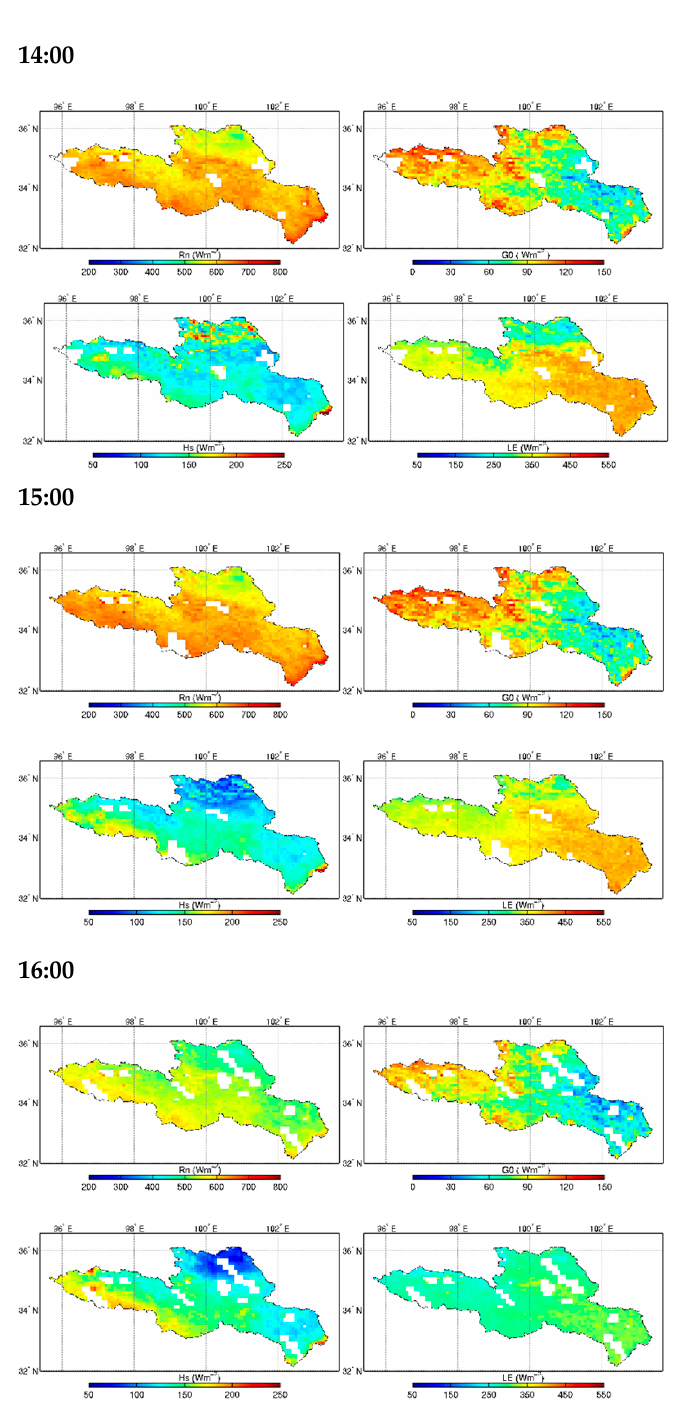
Figure 3. Hourly surface energy fluxes over the study area on 18 August 2019 (11:00 to 16:00 Beijing time).